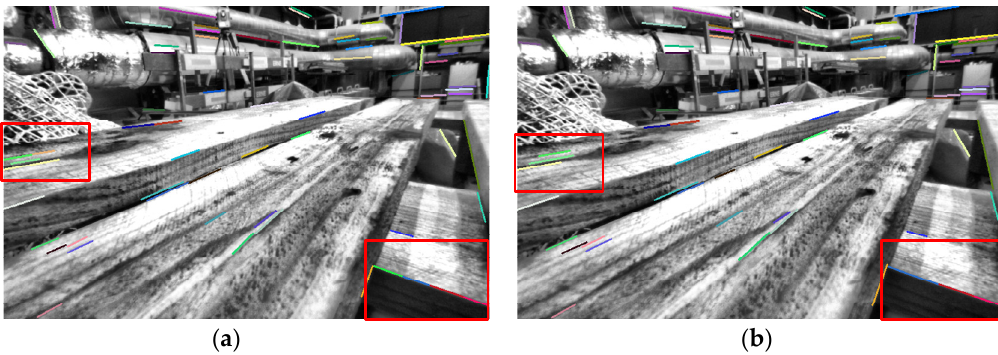
Figure 10. MH_03_medium line feature matching. The line features of the two frames at the previous time ( a ) and the next time ( b ) are matched. The line of the same color represents the corresponding matching line, and the red boxes on the left and right represent the mismatches of the line features.